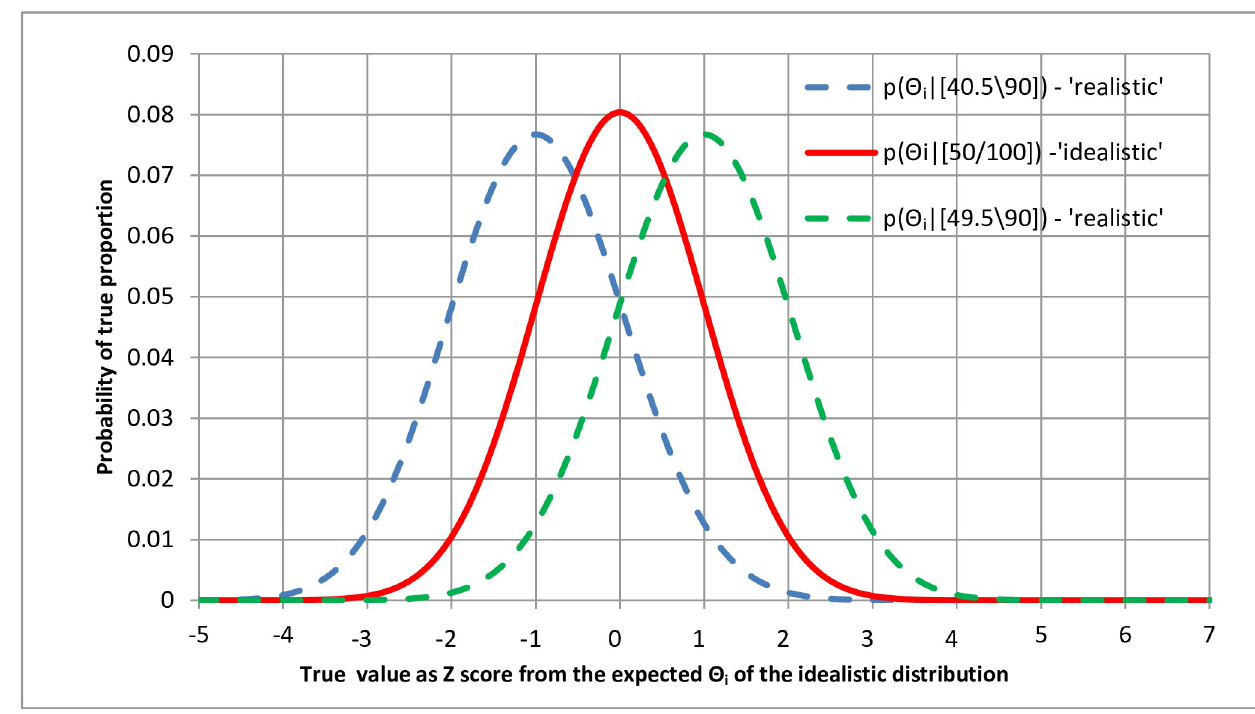
Fig 8. The effect of a probability of impeccable reproducibility on the probability of replication based on Z scores representing Θ